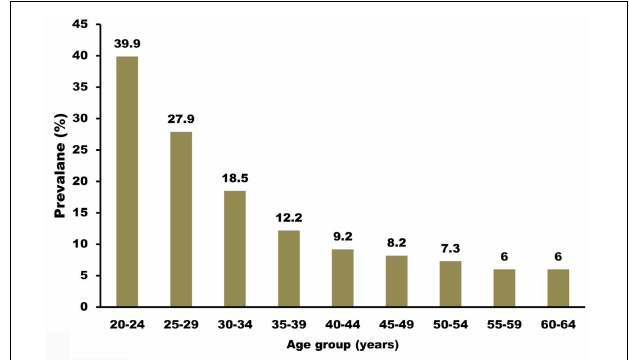
FIGURE 2 | Prevalence of high-risk HPV infection among females undergoing cervical screening. HPV testing in routine cervical screening: cross sectional data from the ARTISTIC trial (Kitchener et al., 2006). Compiled using information from Kitchener et al.